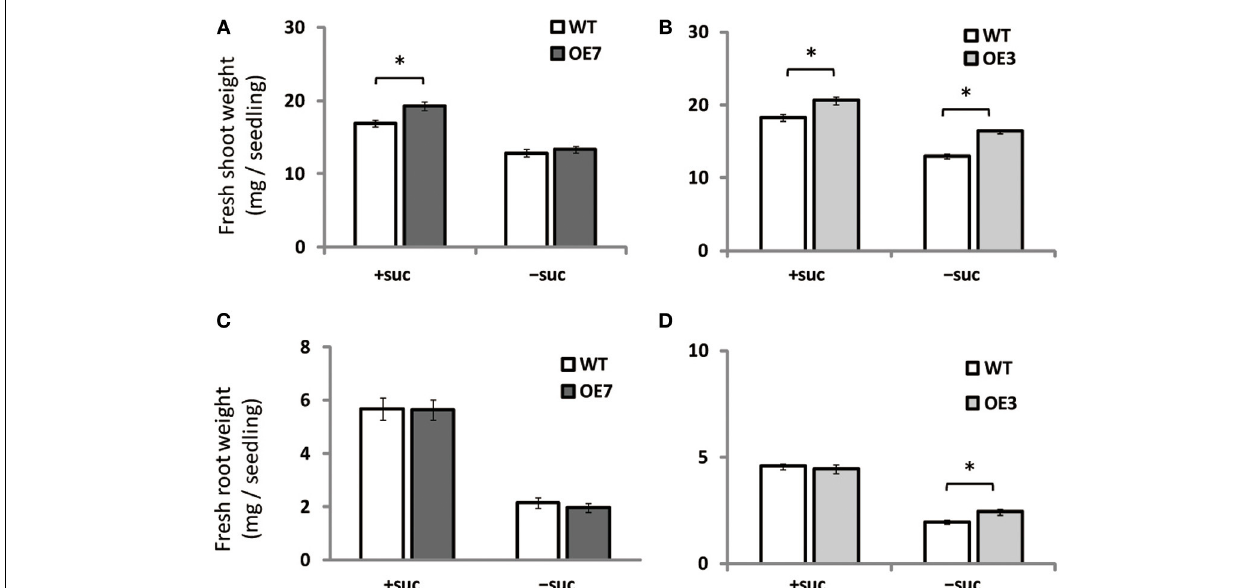
FIGURE 4 | Fresh weight of Arabidopsis WT and the OE7 and OE3 transformant overexpressing At MGD3-GFP in the absence or presence of exogenous sucrose. Plants grown on MS medium supplemented with + suc or − suc for 7d were then transferred to ½MS agar with or without sucrose, respectively, and grown for